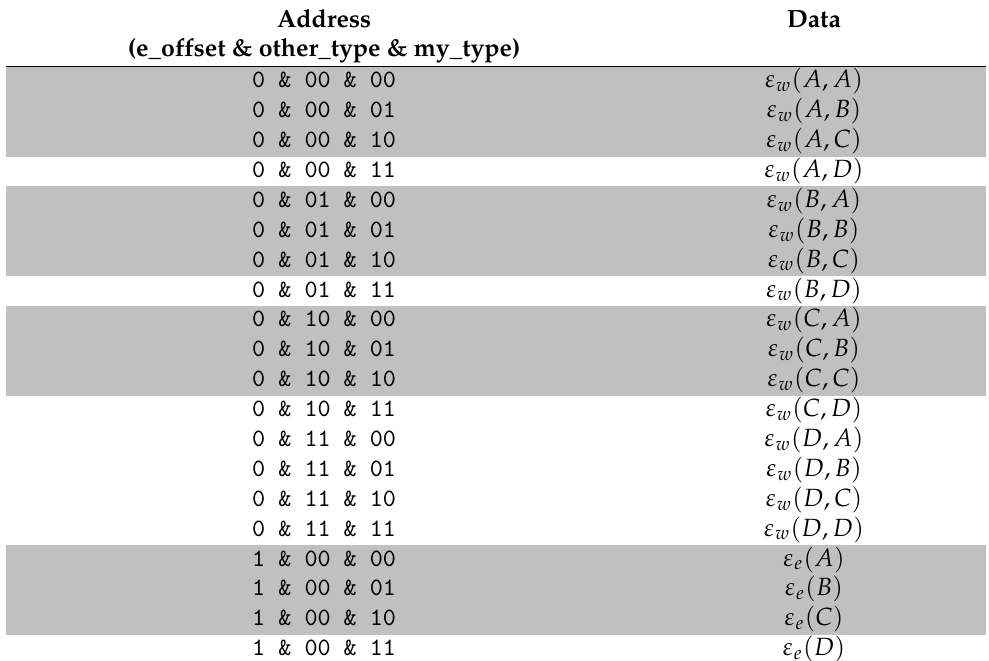
Table 1. Example of BRAM utilization. White background denotes entries that are unused when only three element types are